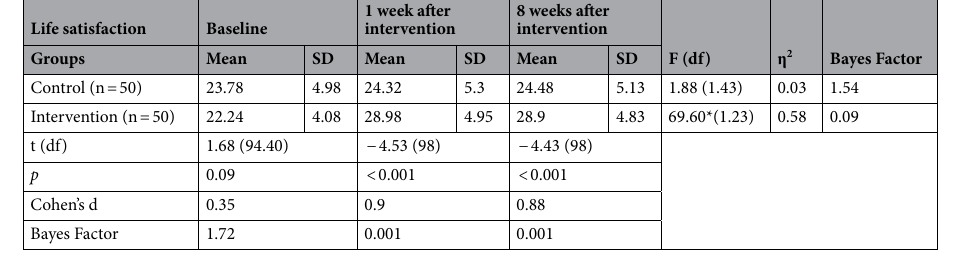
Table 4. The mean scores of life satisfaction in the study groups. * p <